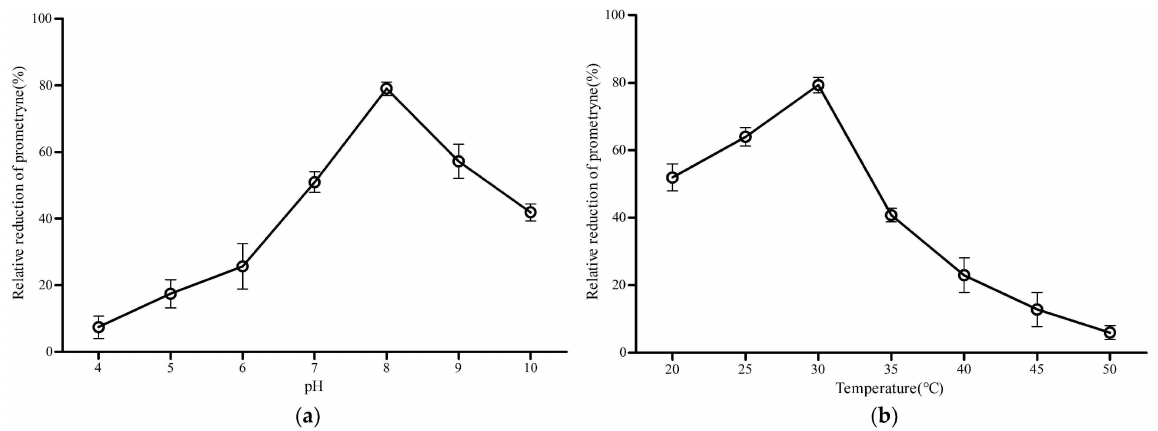
Figure 7. Characterization of the biochemical properties of purified MO5660. ( a ) Effect of pH on MO5660 activity; ( b ) Effect of temperature on MO5660 activity. The error bar indicates one standard